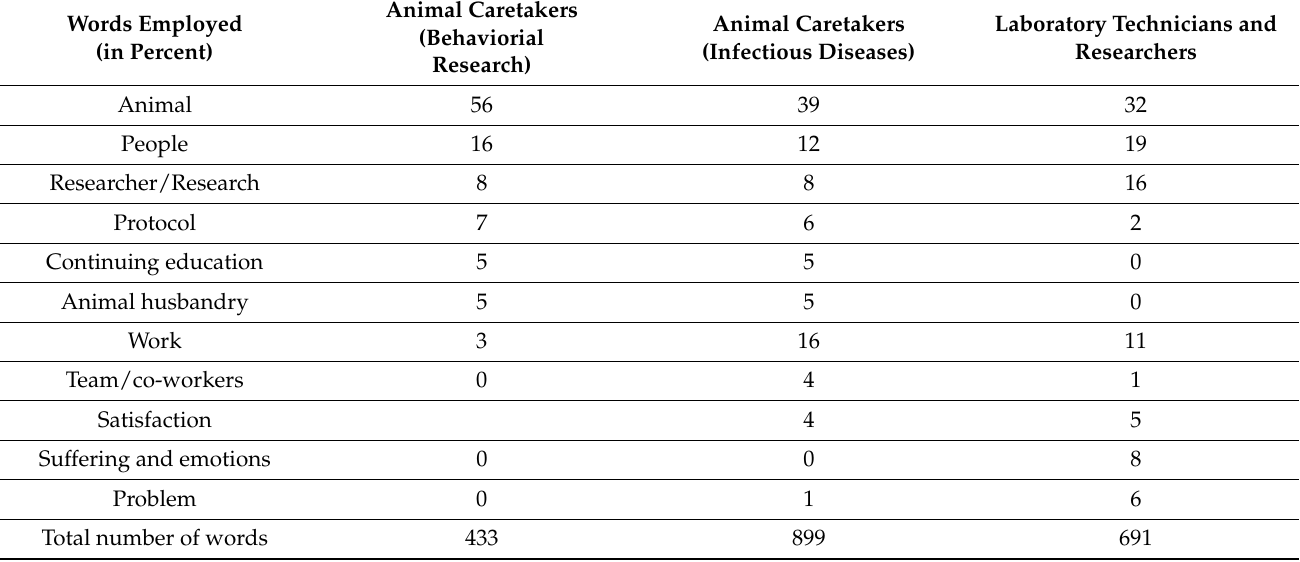
Table 2. The percent occurrence of words used by different categories of stakeholders in animal